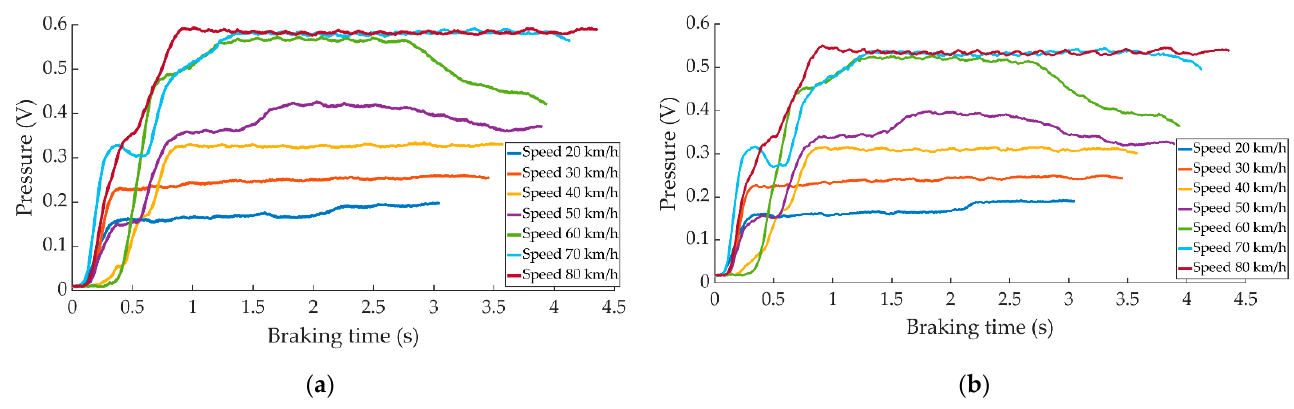
Figure 6. Curves of the data obtained during maintained braking for the different speeds by ( a ) the right pressure sensor and ( b ) left pressure sensor.